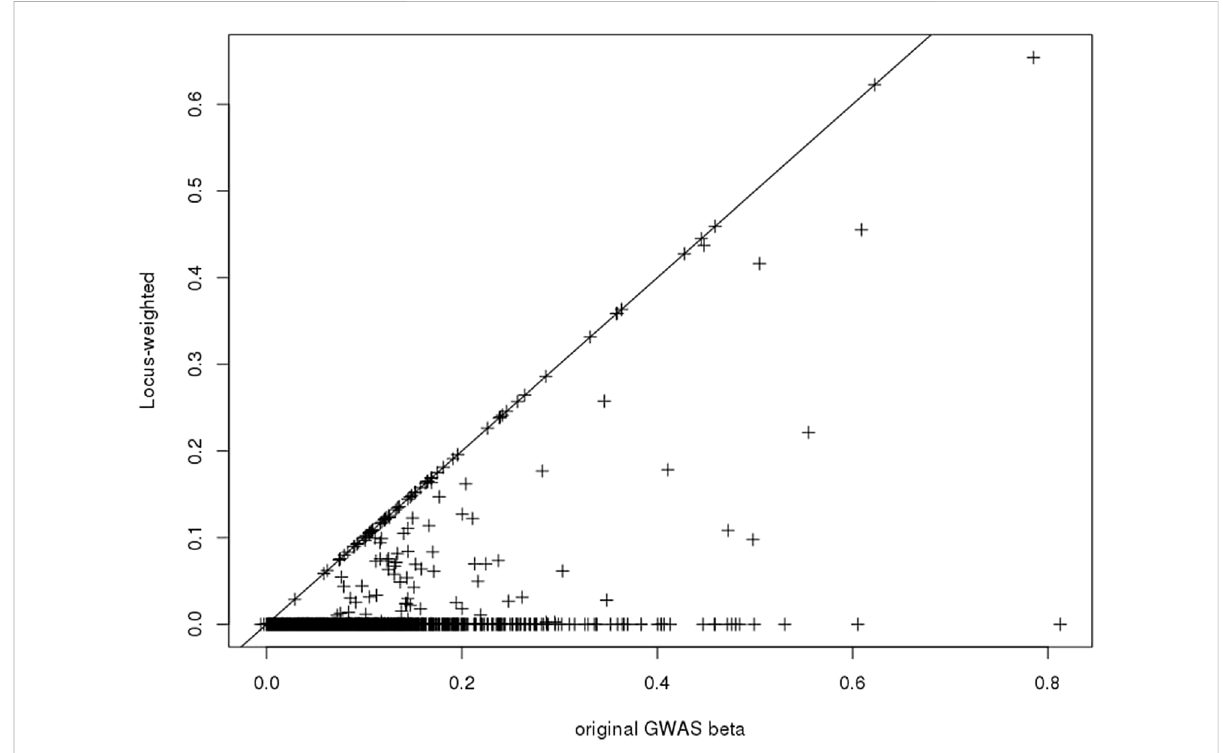
FIGURE 2 Scatter-plot showing the published GWAS association statistics ( ^ β ; horizontal axis) against the Ei -weighted estimated β for diastolic blood pressure (vertical axis). Only SNPs which contributed to the construction of Ei are shown.